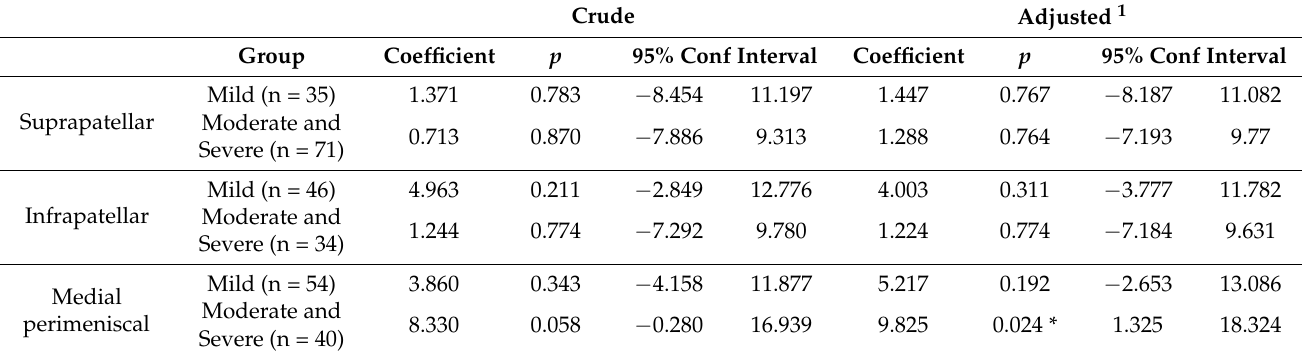
Table 2. Association between site-specific synovial thickness score and knee pain.